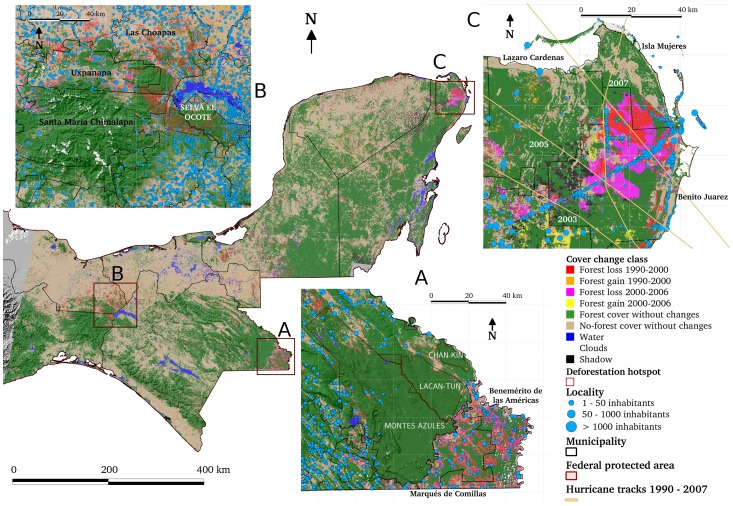
Cover change classification and deforestation hotspots in Southern Mexico.Hotspots were identified where more than 10% of the total municipal land area was losing forest cover during the entire study period (see Figure 3). A) Lacandon forest hotspot; B) Northern Chimalapas hotspot; and C) Benito Juárez-Isla Mujeres hotspot.